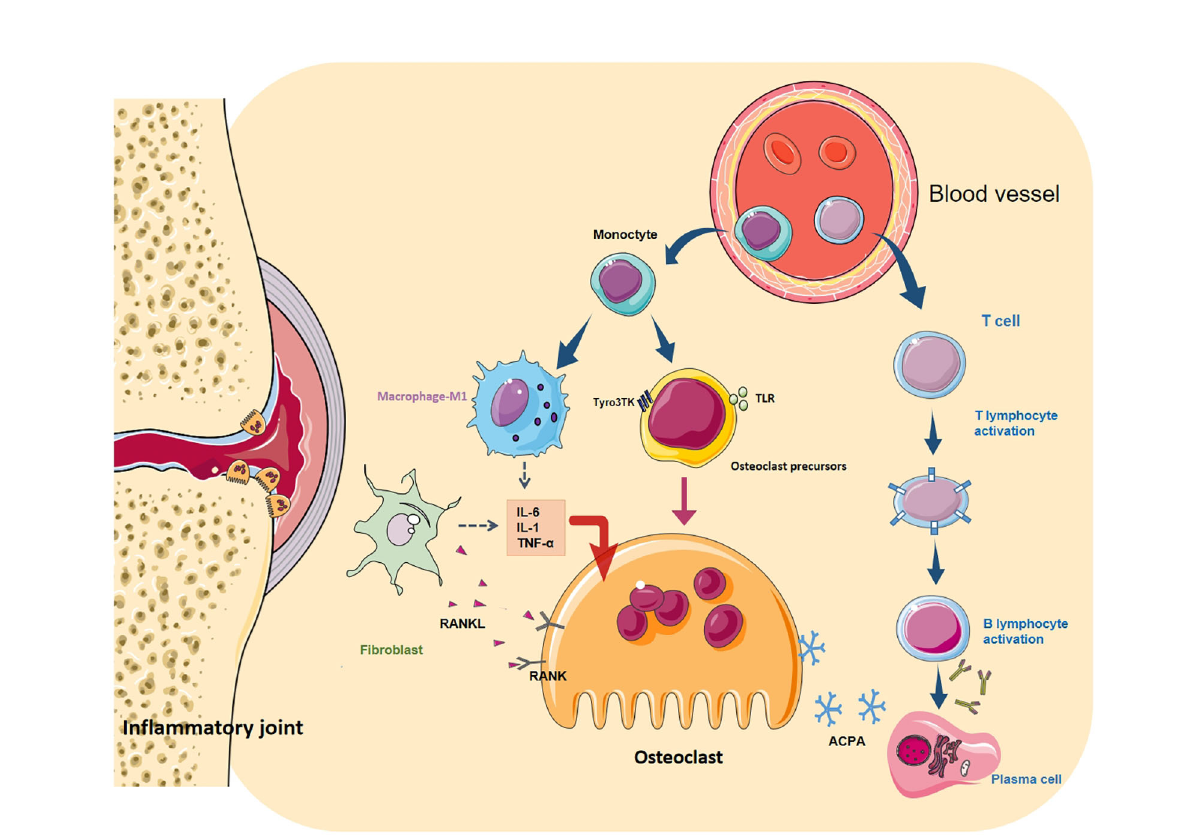
FIGURE 2 Differentiation regulation of osteoclasts. OC differentiation is a multi-step process, in which cytokines and various cell interactions affect the differentiation of OC from the mononuclear to the terminal state. Among them, autoantibodies directly act on OCs (and their precursors) or cooperate with T and B cells to form a vicious circle. Toll-like receptors (TLR) and Tyro3TK on the surface of OCPs bind to their speci fi c ligands to affect OC differentiation. M1 macrophages secrete many pro-in fl ammatory cytokines, chemokines and various matrix lyases to activate OCs and aggravate the in fl ammatory reaction. FLS is the key cell in RA bone destruction. Various pro-in fl ammatory factors allow it to express RANKL in large quantities. It binds to RANK on the surface of macrophages and OCs and promotes the maturation of OCs through NF- k B signal